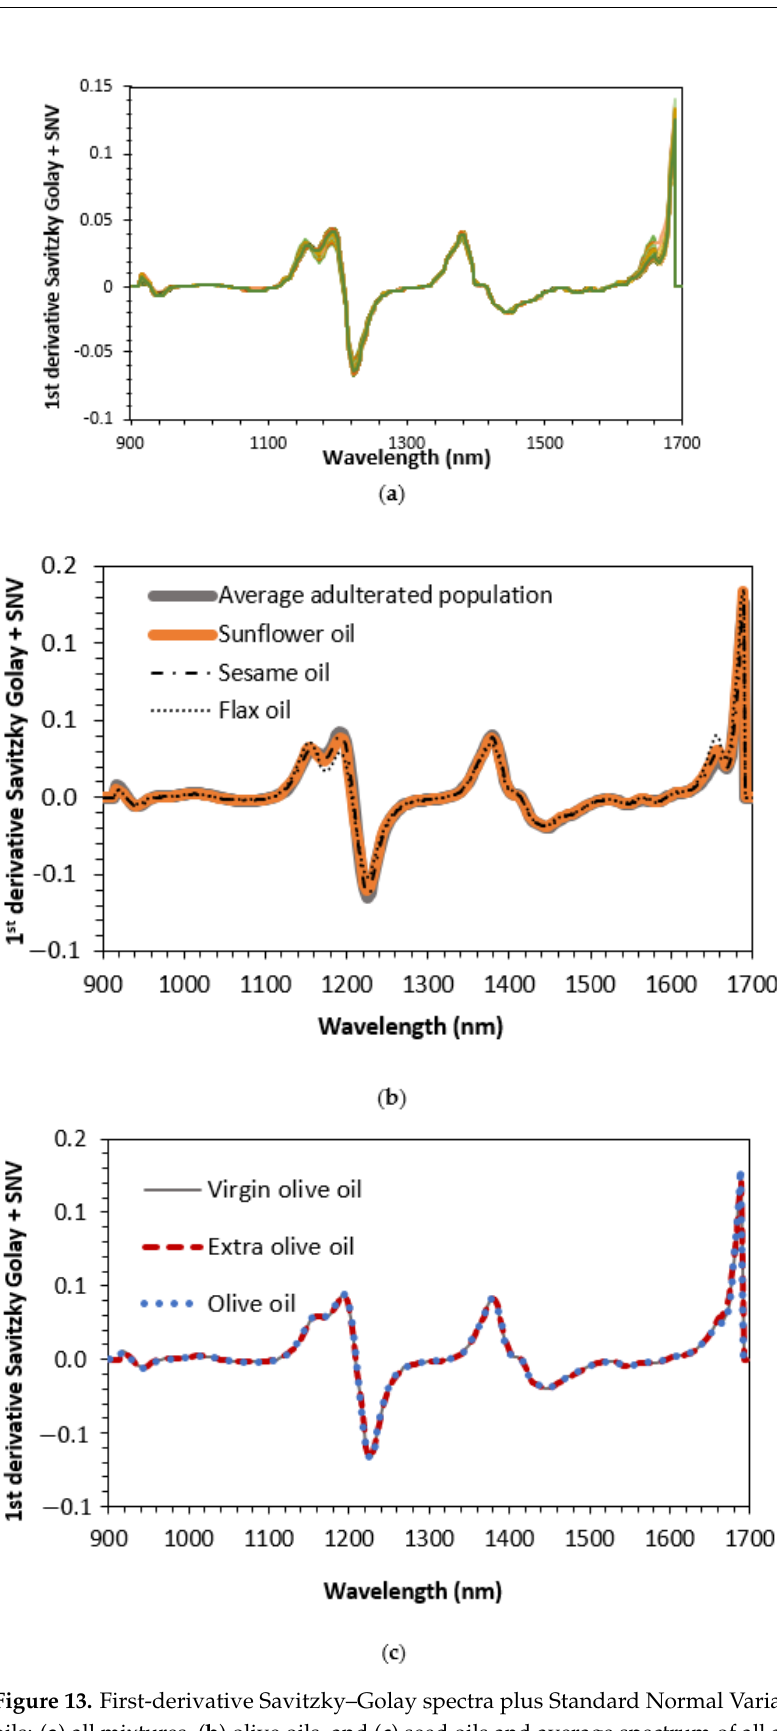
Figure 13. First-derivative Savitzky–Golay spectra plus Standard Normal Variate (SNV) of all pure oils: ( a ) all mixtures, ( b ) olive oils, and ( c ) seed oils and average spectrum of all adulterated samples. After plotting the spectra, principal component analysis (PCA) was carried out for each type of olive oil with its corresponding mixtures and all sample sets (N = 96) involved in this study. Different approaches were evaluated for PCA analysis using SG first and second derivatives. Figure 14 summarizes the best-obtained results.